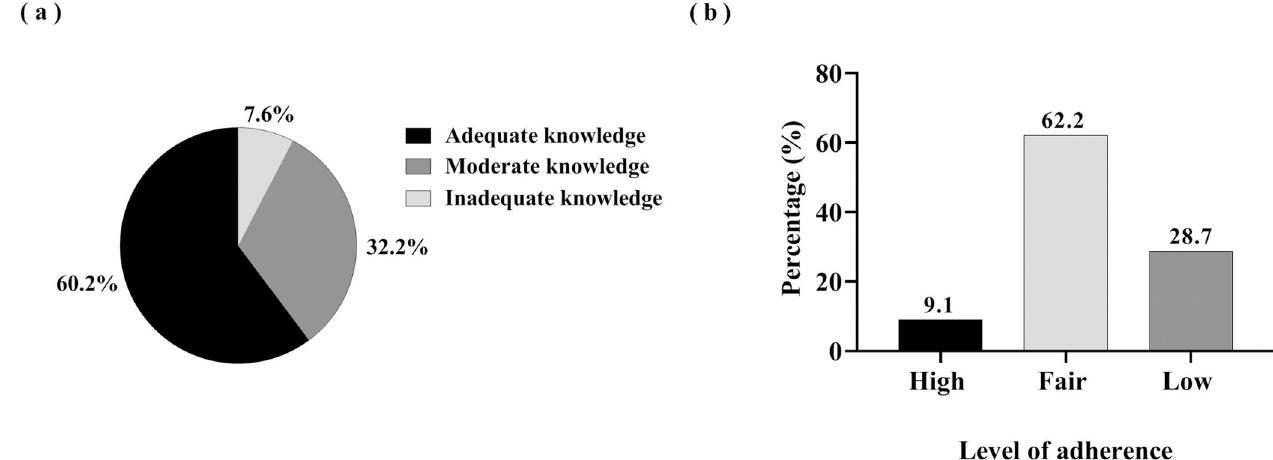
Fig 1. Level of: (a) knowledge about COVID-19 and (b) adherence to COVID-19 safety protocols among respondents (N = 339).